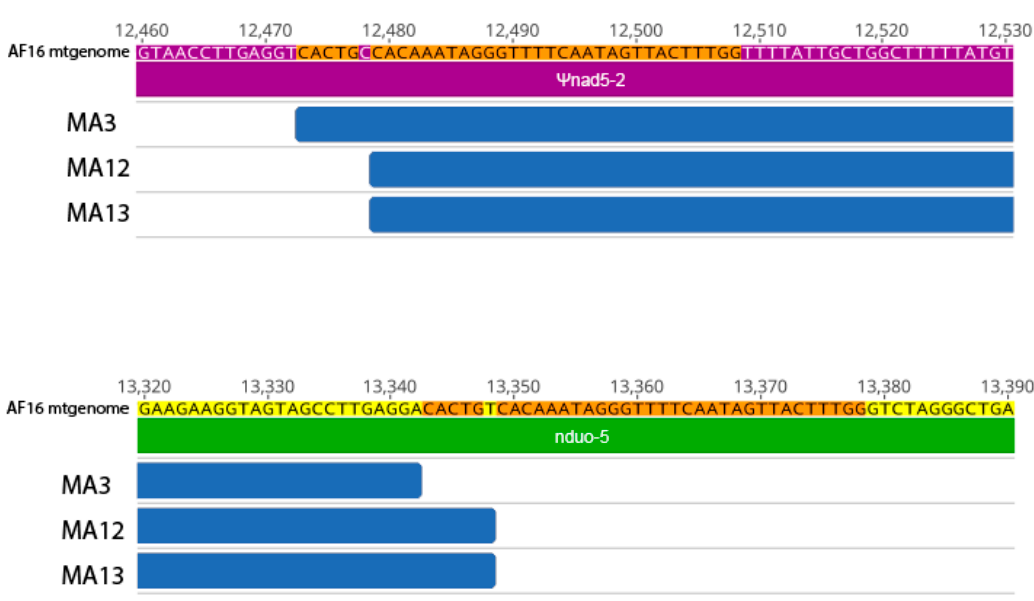
Figure 2. Large deletions harbored by AF16 MA3, MA12, and MA13 mitochondrial genomes. Annotations and base positions are based on the reference AF16 mtgenome. The top region shows positions 12,460 – 12,530, which are within ψ nad5-2, while the bottom region shows positions 13,320 – 13,390, within nduo-5 . The deletion regions, referred to collectively as nad5 Δ and represented in blue , are 870 bp in length and span from ψ nad5-2 into nduo-5 . While MA13 and MA12 share the same nad5 Δ , the deletion in MA3 is shifted +6 bases. None of the AF16 MA lines had evidence for more than one nad5 Δ deletion variant. The 5 bp and 30 bp direct repeat motifs flanking the deletions are shown in orange.